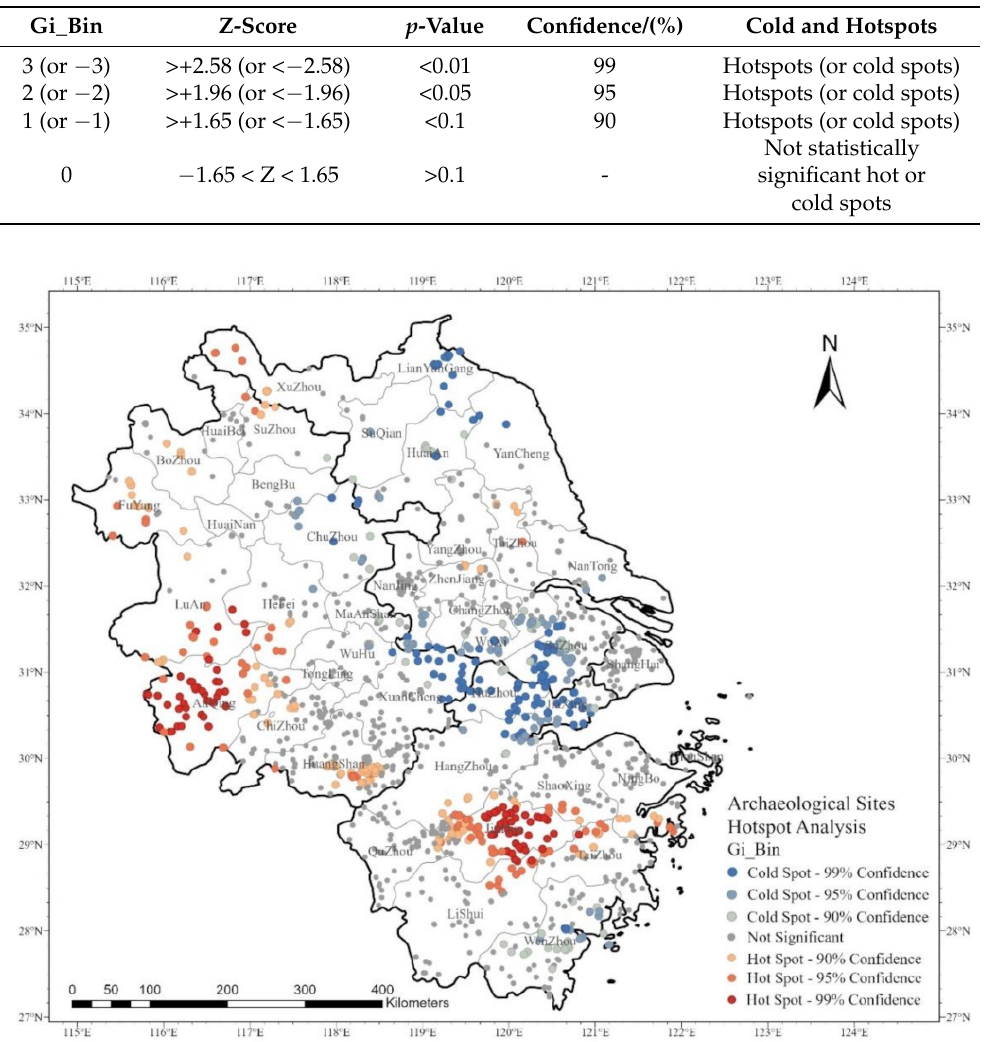
Figure 8. Significant distribution of cold- and hot-spots at Archaeological Sites. The hotspots in the research area are mainly distributed in Anhui and Zhejiang provinces, while the cold spots are mainly distributed at the intersection of Anhui, Zhejiang and Jiangsu provinces: parts of northern Anhui (33 ◦ ~35 ◦ N, 115 ◦ ~117 ◦ E), such as Fuyang and Bozhou, and western Anhui (30 ◦ ~32 ◦ N, 116 ◦ ~117 ◦ E), such as Anqing, Lu’an and Hefei. In the central region of Zhejiang (28 ◦ ~30 ◦ N, 119 ◦ ~131 ◦ E), such as Jinhua, Taizhou and Ningbo, the positive Z-score and p -value obtained by Getis-Ord Gi* statistics are relatively high, corresponding confidence value is relatively high and the high-value clustering degree is relatively large, and these areas have become hotspots of spatio- temporal distribution of Archaeological Sites. The corresponding cold spots are mainly distributed at the intersection of the three provinces (30 ◦ ~32 ◦ N, 119 ◦ ~121 ◦ E), such as Suzhou, Jiaxing, Huzhou, Xuancheng and Wuxi. In some regions, the Z-score shows a trend of gradual decrease. The negative Z-score is small, and the low-value clustering is close, making it a cold spot for spatio-temporal distribution of Archaeological